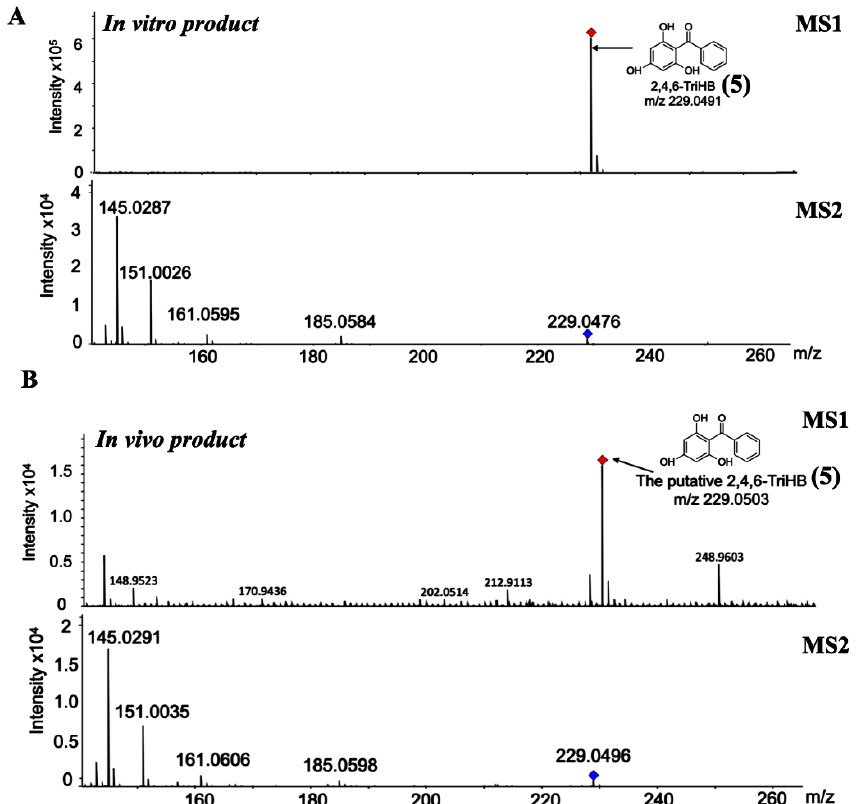
Figure 3. Identification of 2,4,6-TriHB ( 5 ) by using the high-resolution LC-ESI( − )-QTOF-MS/MS (CID of 35 eV). ( A ) The mass spectrum of 2,4,6-TriHB ( 5 ) ( m/z 229.0491) with the MS/MS fragmentation pattern from the enzymatic reaction of GmBPS, where benzoyl-CoA ( 3 ) and malonyl-CoA ( 4 ) were the substrates. ( B ) The putative mass spectrum of 2,4,6-TriHB ( 5 ) ( m/z 229.0503) and its fragmentation profile obtained from the bioconversion of benzoate ( 2 ) by E. coli BL21(DE3)pLysS harboring pETDuet-BadA - GmBPS .